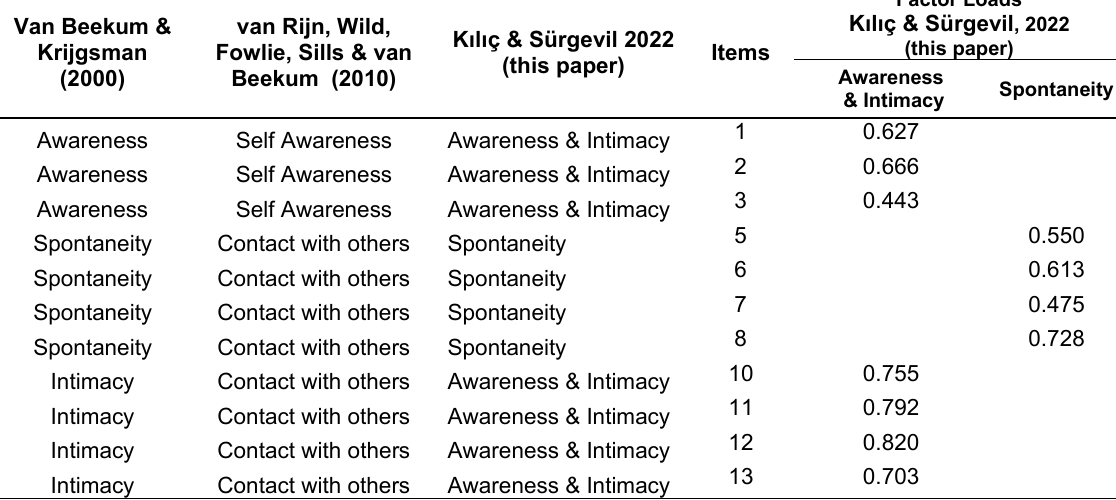
Table 2: Factor Loads of Scale Dimension